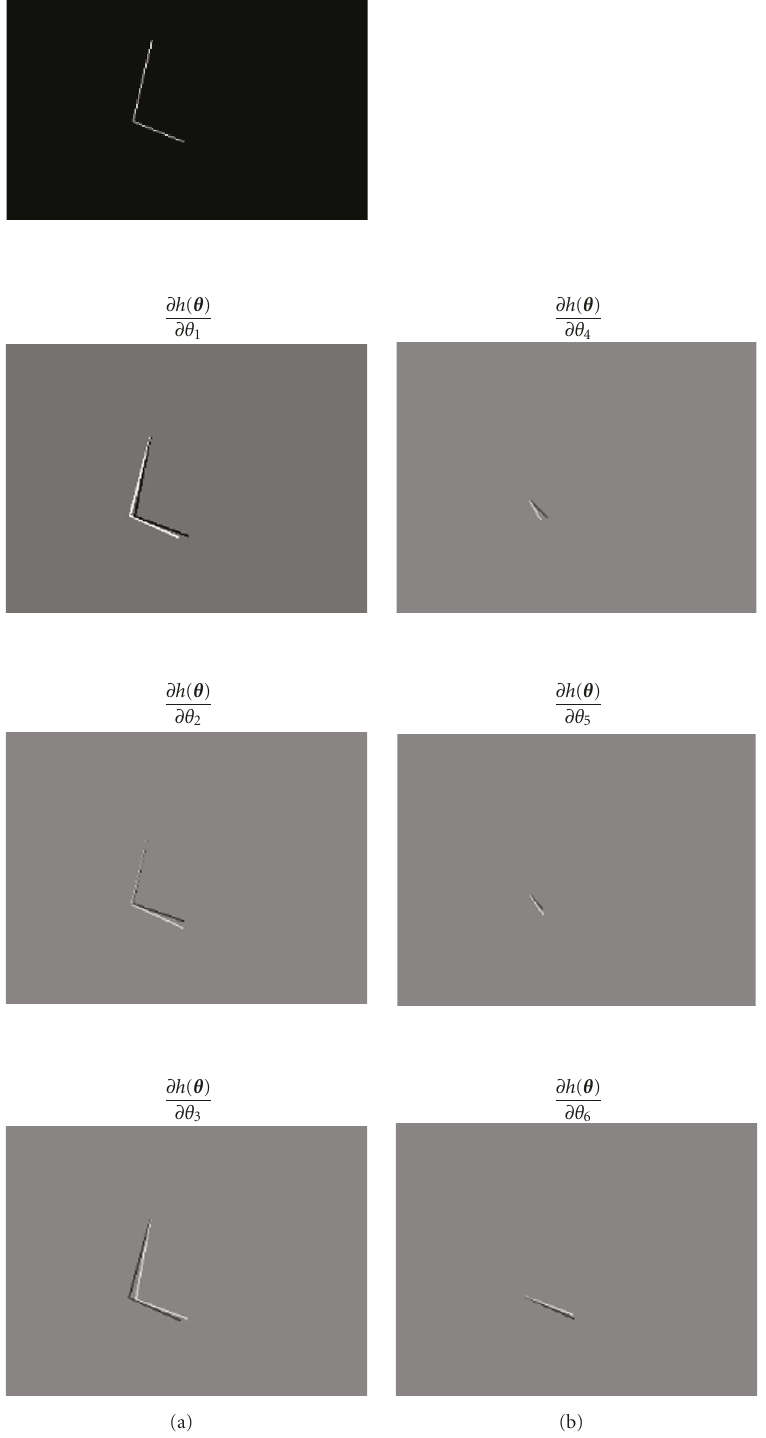
Figure 5: The M c ( θ ) function and its partial derivatives for the case of Figure